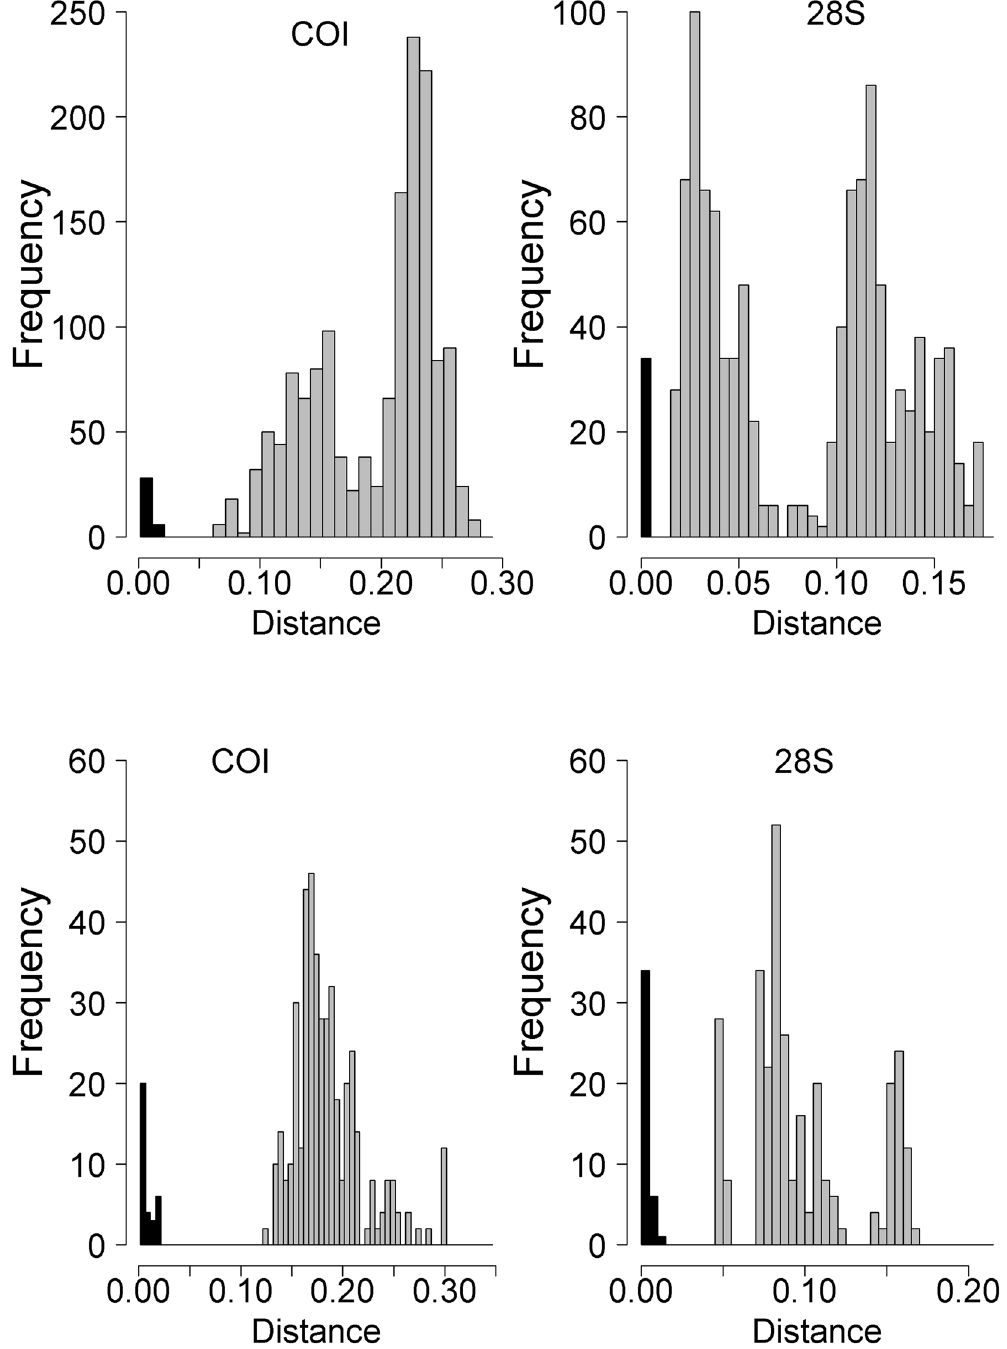
Figure 3. Intraspecific (black) and interspecific (gray) distances for Coccidae ( A ) and Diaspididae ( B ), for COI (left) and 28S (right). Distances were calculated with the Kimura two-parameter nucleotide substitution